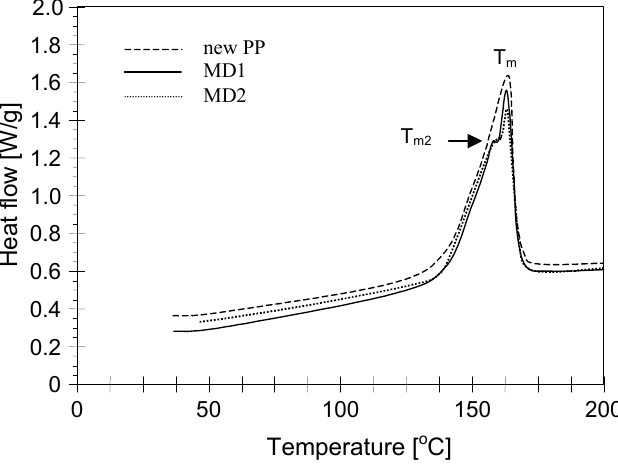
Figure 15. DSC heating curves (I scanning) of new Accurel PP S6/2 membrane and membrane samples removed from MD1 and MD2 modules.